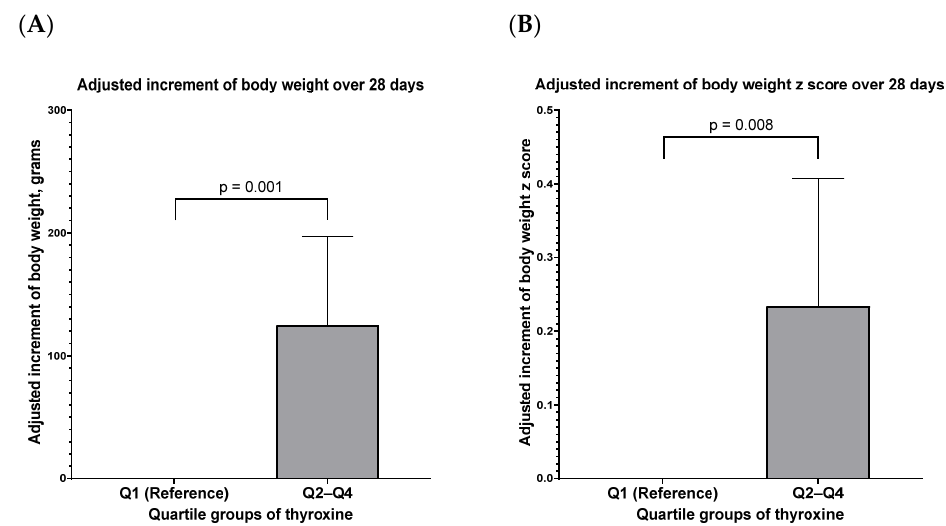
study as a reference, infants with total thyroxine in Q2–Q4, compared to infants with total thyroxine in Q1, had a significantly higher body weight increment and higher body CI: confidence interval; GA: gestational age; SGA: small for gestation age; RDS: respiratory distress syndrome; TT4: total serum thyroxine. Multivariate analysis by generalized estimating equations was performed for each weight z-score increment over the 28 days of observation after the screening at stage II dependent variable and independent variable. Statistical significance was assumed for p < 0.05 (indicated in bold). (Figure 3, Table S3).